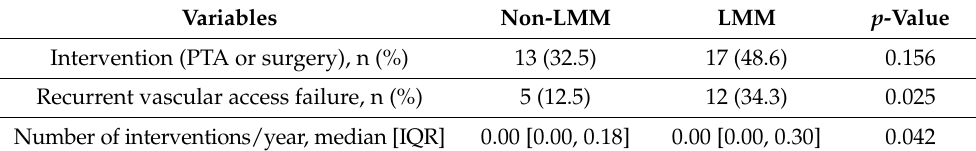
Table 3. Comparison of the incidence of vascular access failure according to muscle mass.